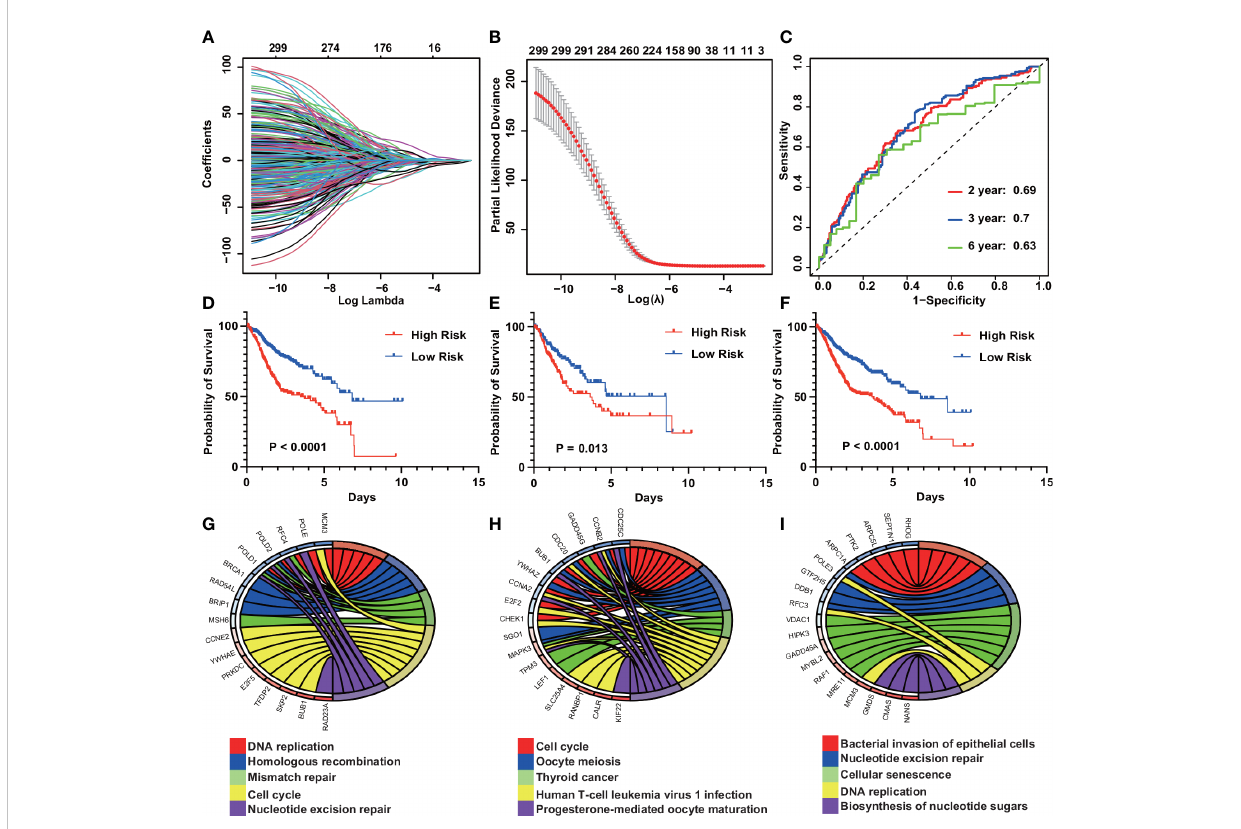
FIGURE 4 Construction of an IGS-based risk prediction model. (A) Least absolute shrinkage and selection operator (LASSO) coef fi cient pro fi les of the fractions of IGSs. (B) Ten fold cross-validation for tuning parameter selection in the LASSO model. (C) Risk score measured by survival receiver operating characteristic (ROC) curves in the training cohort. The area under the ROC curve (AUC) was 0.69, 0.7, and 0.63 at 2, 3, and 6 y, respectively. (D – F) Kaplan-Meier curves for overall survival by risk score group in the training (D) , validation (E) and entire cohorts (F) . (G – I) KEGG pathway analysis of the genes in Gene Sets 1 –